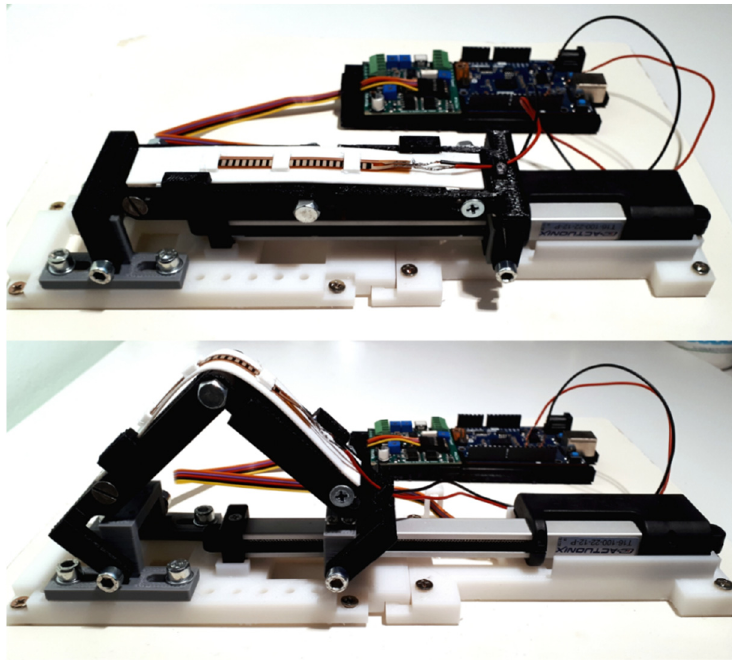
Figure 8. Test bench for sensors used for fixed radius of curvature.